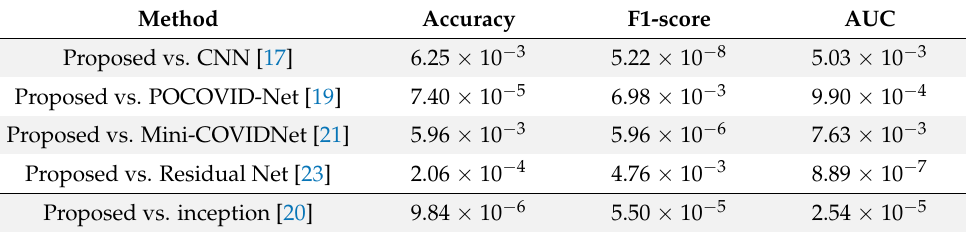
Table 3. The statistical results obtained from the Friedman test with a significance threshold σ =